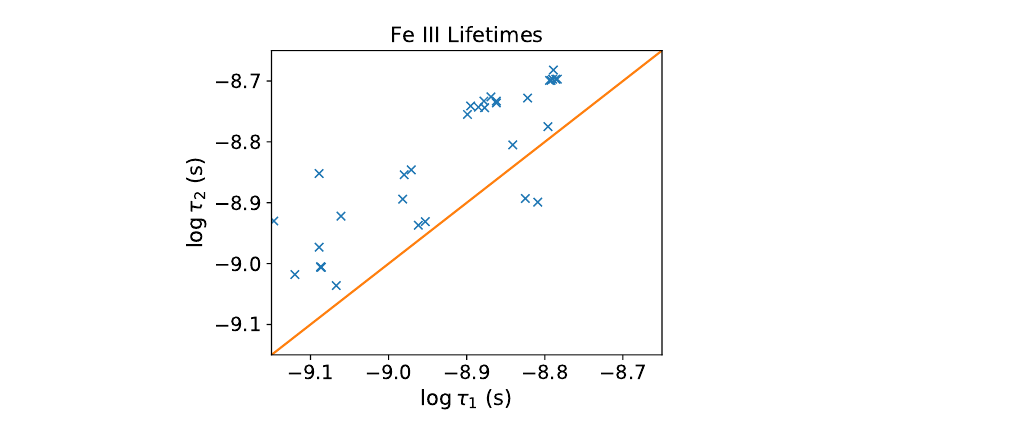
Figure 5. Comparison of radiative lifetimes for 44 levels of the 3d 5 4p configuration in Fe III derived from the A -values from atom_BB14_144 ( τ 1 ) and Ref. [39] ( τ 2 ).